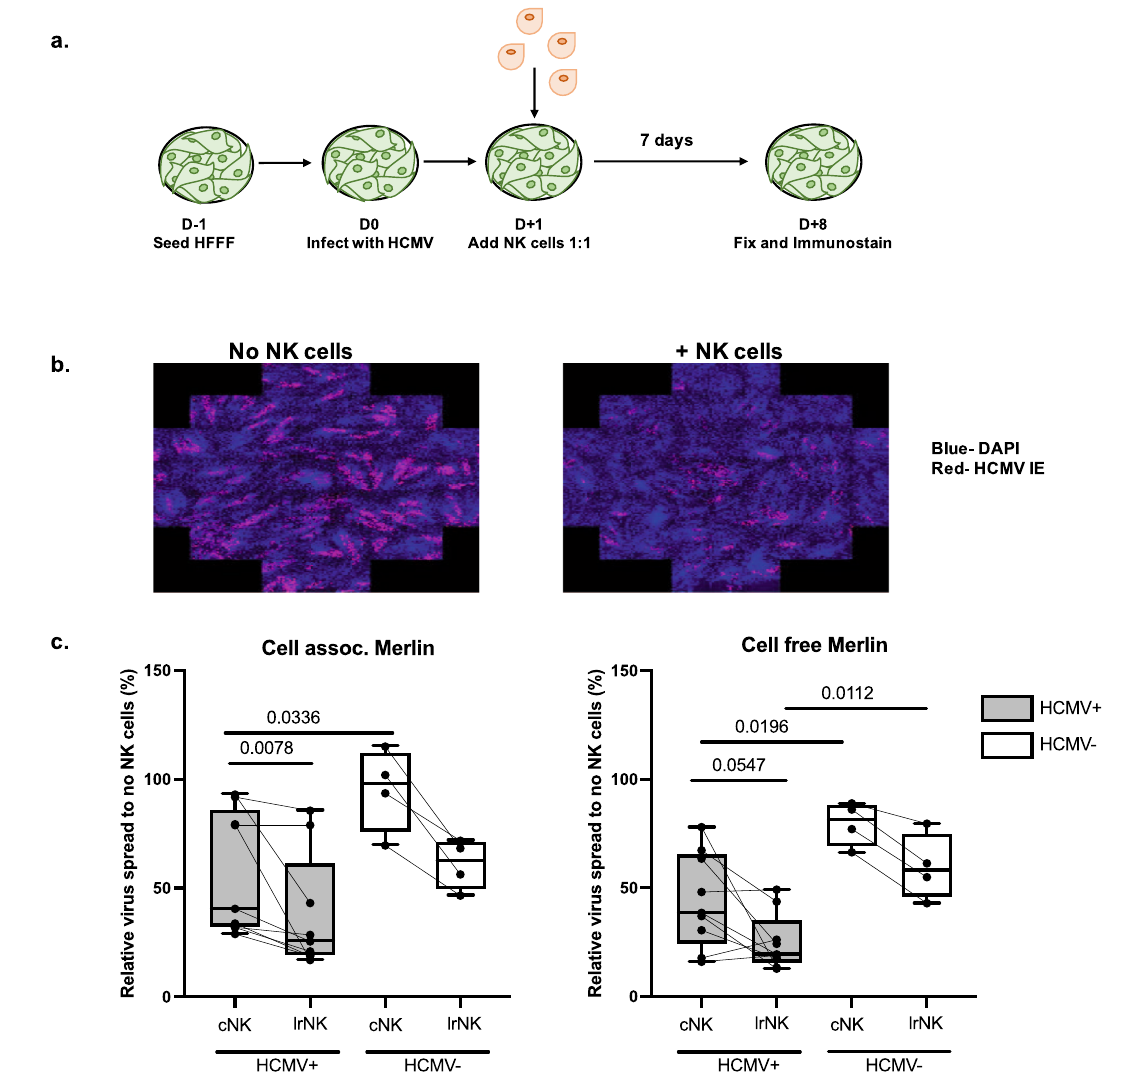
Fig.2|lrNKcellscontrolHCMVreplicationinvitro.a SchematicofVDA.Seeded fi broblasts were infected with HCMV at ~0.01 MOI/well with sorted cNK or lrNK addedafter24h.Afterafurther7days,cultureswere fi xedandimmunostainedfor DAPI and HCMV-IE (secondary antibody on AF568). b Immunostained plates were analysed on a Hermes Wiscan scanning microscope with MetaMorph imaging software. Images were generated using tiles encompassing 50% of the well. c NK subset control of HCMV spread relative to infected cells without NK cells. Paired